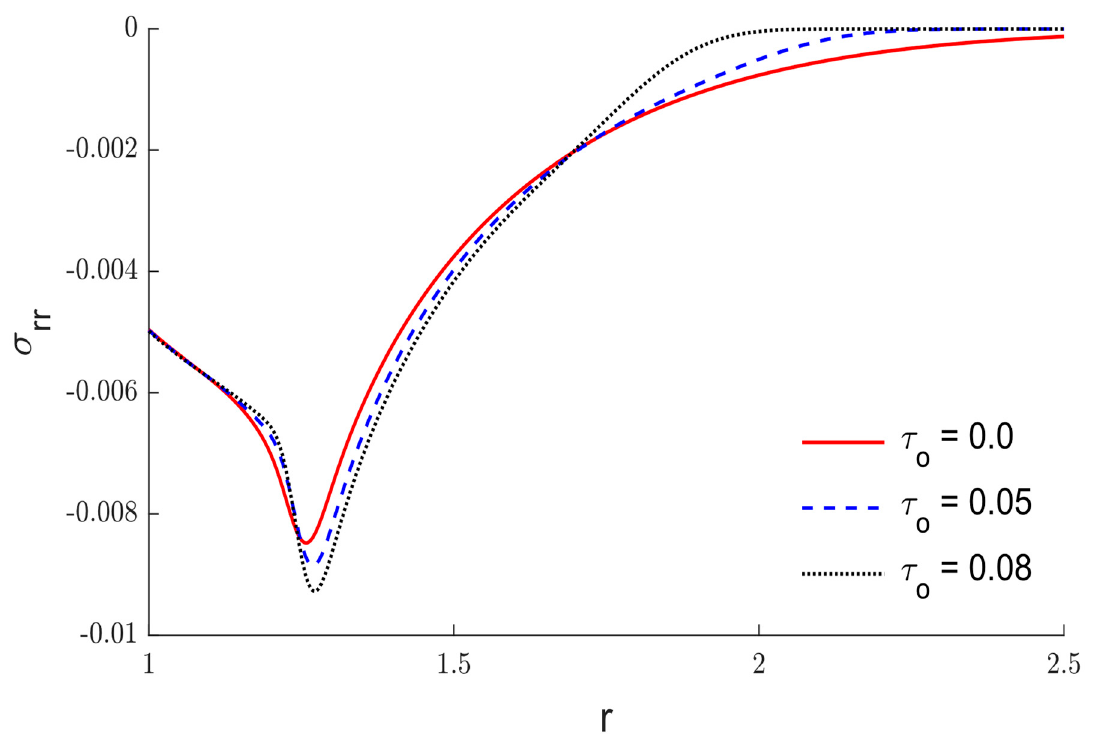
Figure 8. The impacts of thermal delay time τ o in the variations of radial stress σ rr , when K n = − 0.6.